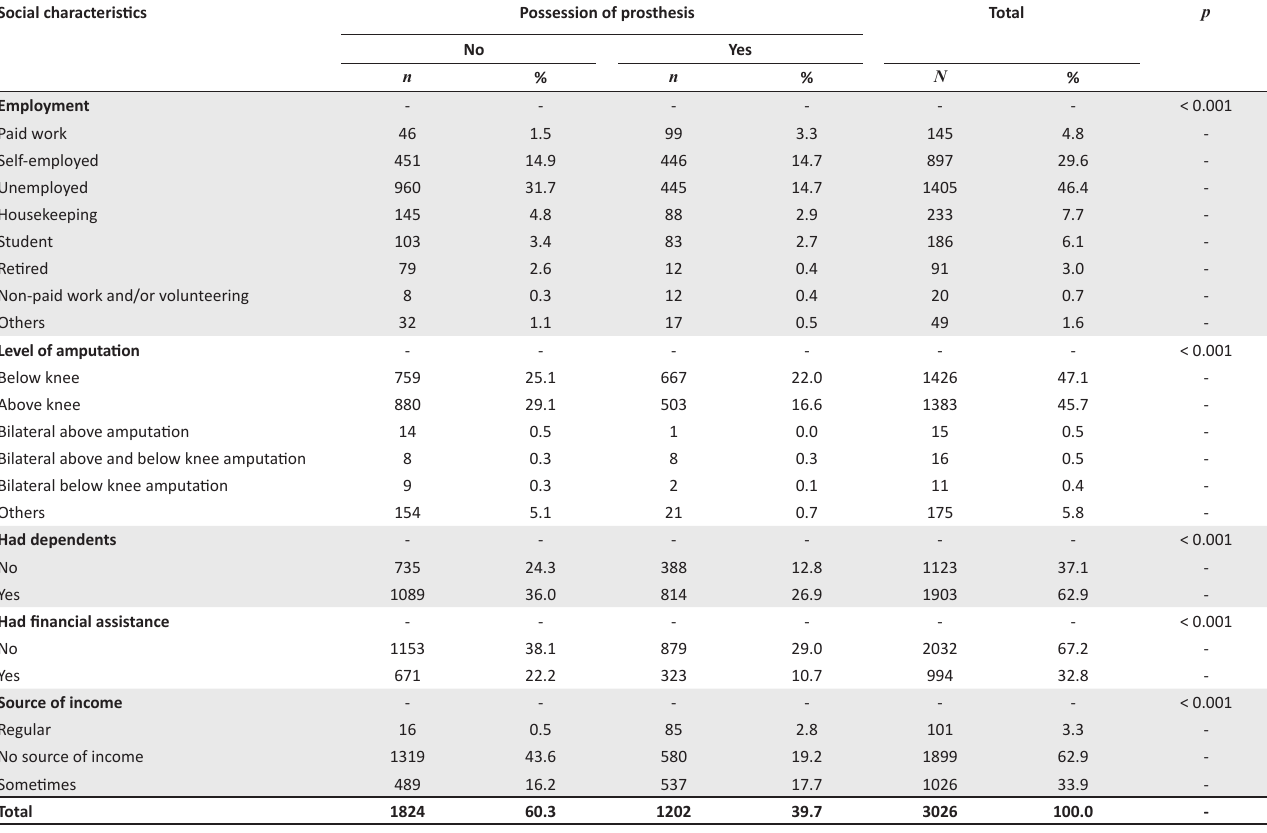
TABLE 2: Socio-economic characteristics of participants with or without prosthetic devices. Social